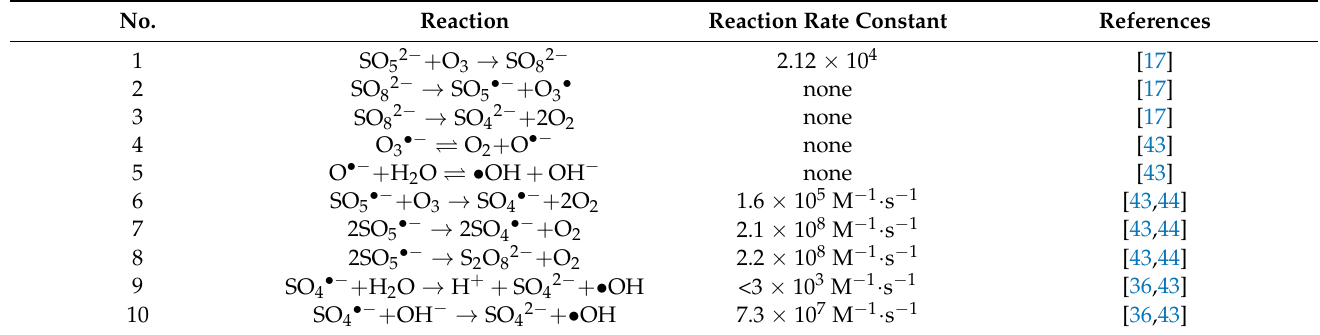
Table 1. The reaction equations for the formation of •OH and SO 4 •− and the corresponding reaction rate constants.